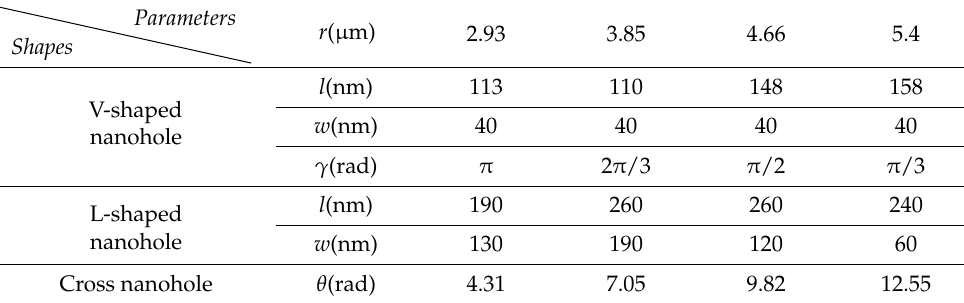
Table 1. Structure parameters of three metalenses with f = 4.5 µ m.